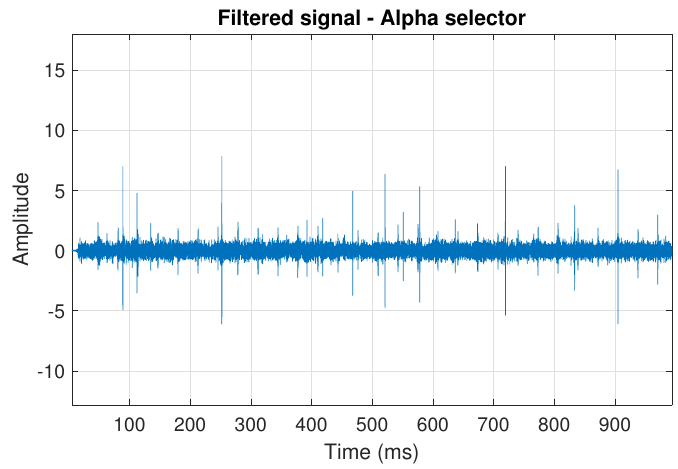
Figure 23. Filtered signal s 3 by Alpha